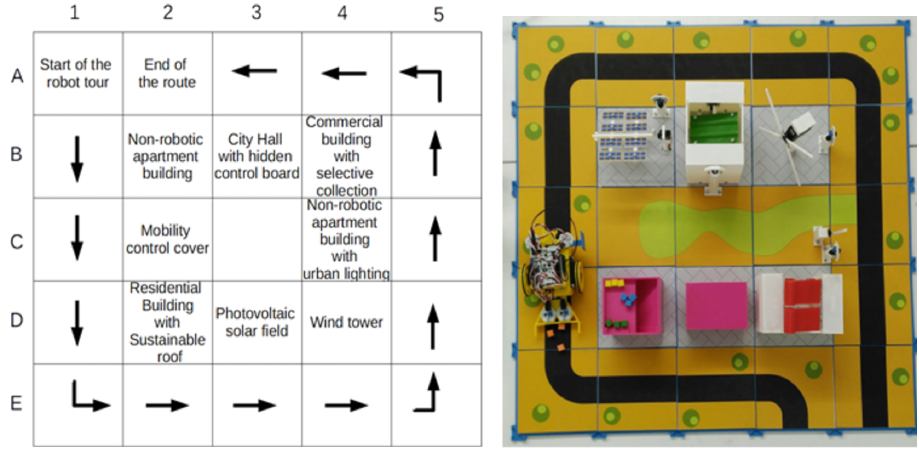
Figure 2. “Sustainable City” STEAM project developed in